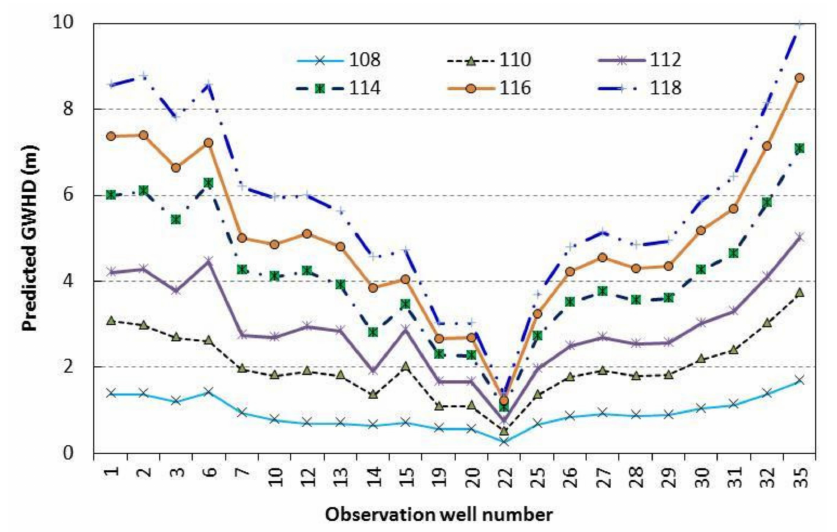
Figure 12. The relation between GWHD and observation well number at different boundary